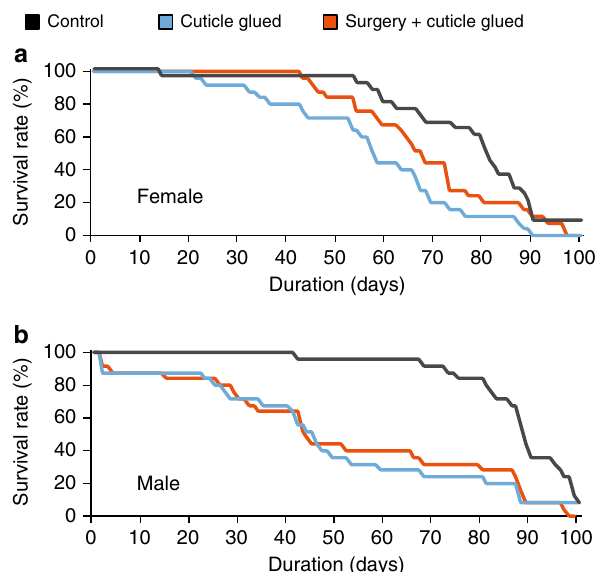
Fig. 2 Survival curves of male and female fl ies after laser